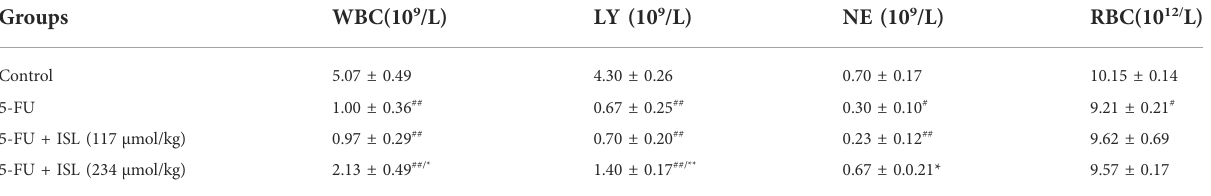
TABLE 2 Changes in indexes of blood routine in mice (n = 3 in each group).